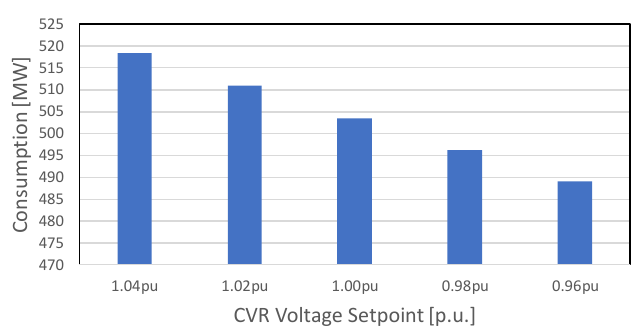
Figure 7. Total energy consumed in June for different CVR setpoints.